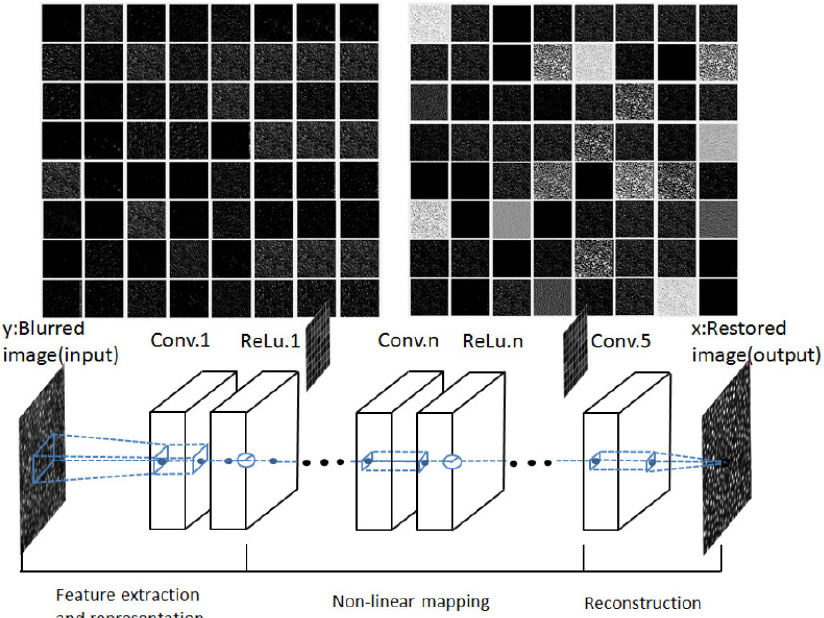
Fig. 2. The schematic diagram of the CNN used for AO retinal image deblurring. The network comprises ¯ve layers that combine convolutions with element-wise recti¯ed linear units (ReLU). A blurred image goes through the layers and is transformed into a restored one, and some sample feature maps are drawn for visualization. Reproduced from Ref.